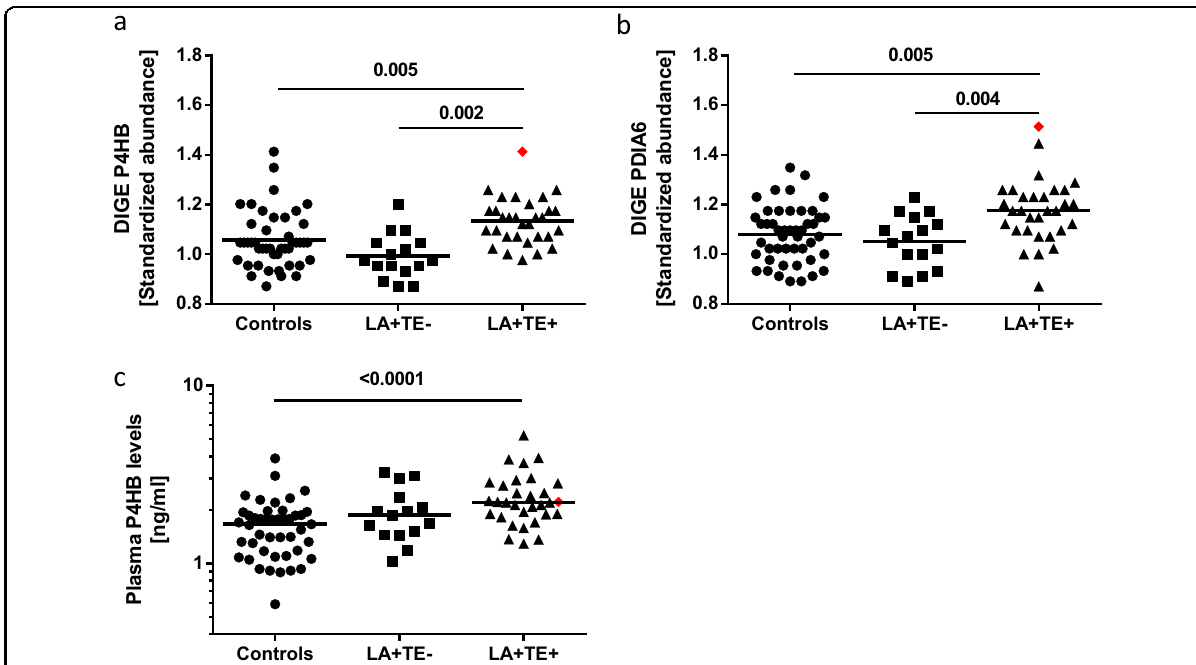
Fig. 2 Analysis of protein disul fi de isomerases (P4HB and PDIA6) in human platelets and plasma between LA + TE + patients and control groups. a LA + TE + patients had signi fi cantly increased protein abundance of P4HB in platelets compared to healthy controls ( p = 0.005) or patients without a history of TE ( p = 0.002). b Standardized abundance of PDIA6 was signi fi cantly increased in LA + TE + patients compared to healthy controls ( p = 0.005) and LA + TE − patients ( p = 0.004). c In addition, P4HB levels in plasma were signi fi cantly elevated in LA + TE + patients compared to healthy controls ( p = ≤ 0.0001). Each dot represents a measurement of a single patient. The patient with CAPS is visualized as a red rhombus. The line between the dots of Fig. 2a, b represents the mean (FDR-corrected t -test) and of Fig. 2c the median (Wilcoxon-Mann-Whitney-U-Test). LA lupus anticoagulant, TE thromboembolism, 2D-DIGE two-dimensional differential in-gel electrophoresis, CAPS catastrophic antiphospholipid antibody